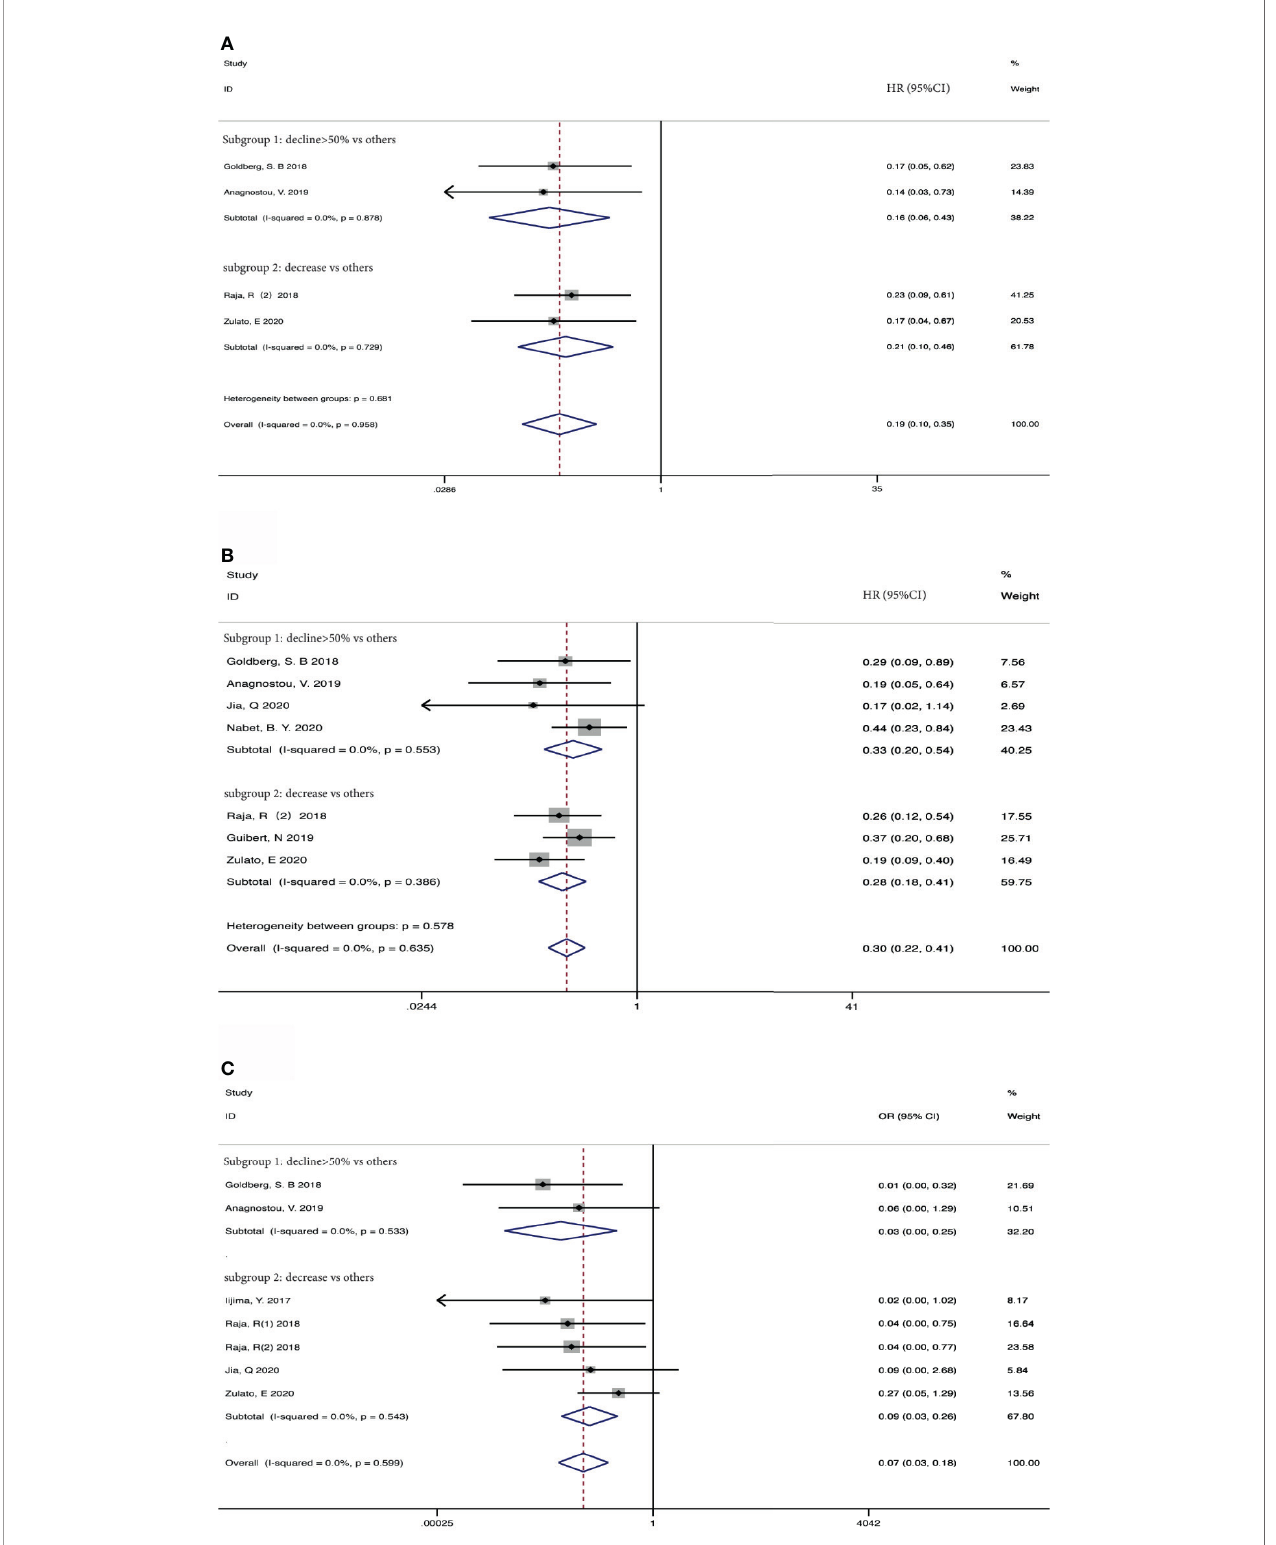
FIGURE 5 | Subgroup analysis the associations between early decrease of ctDNA and (A) overall survival, (B) progression-free survival, (C) objective response